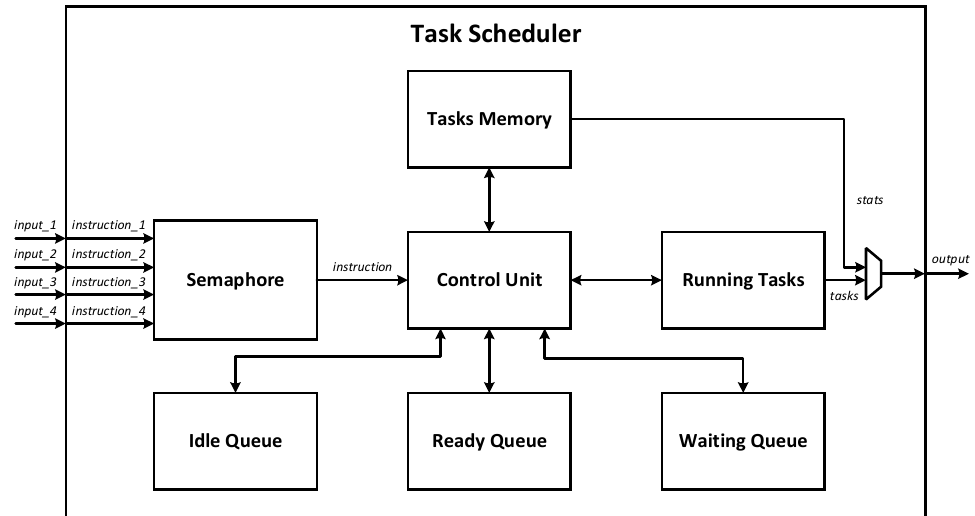
Figure 3. Block diagram of proposed task scheduler.